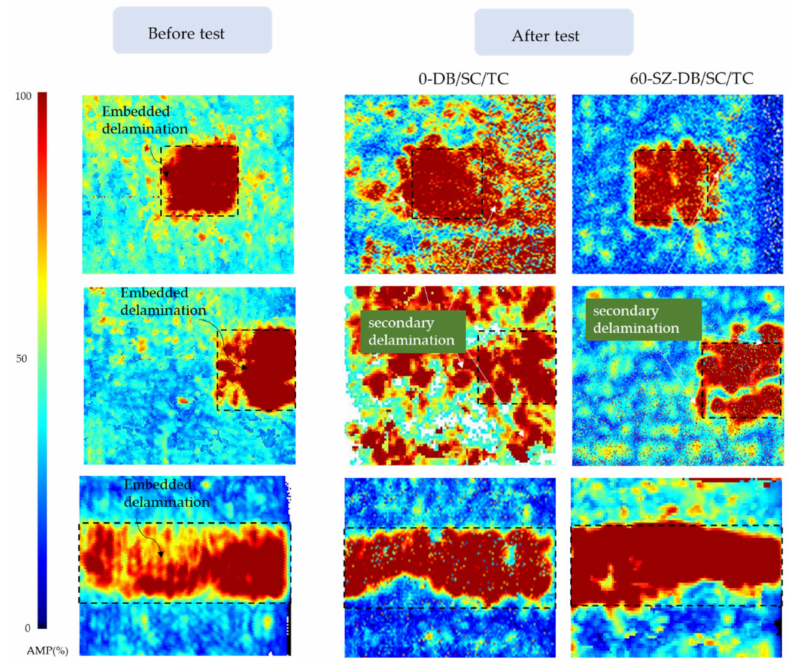
Figure 11. Delamination damage identification by